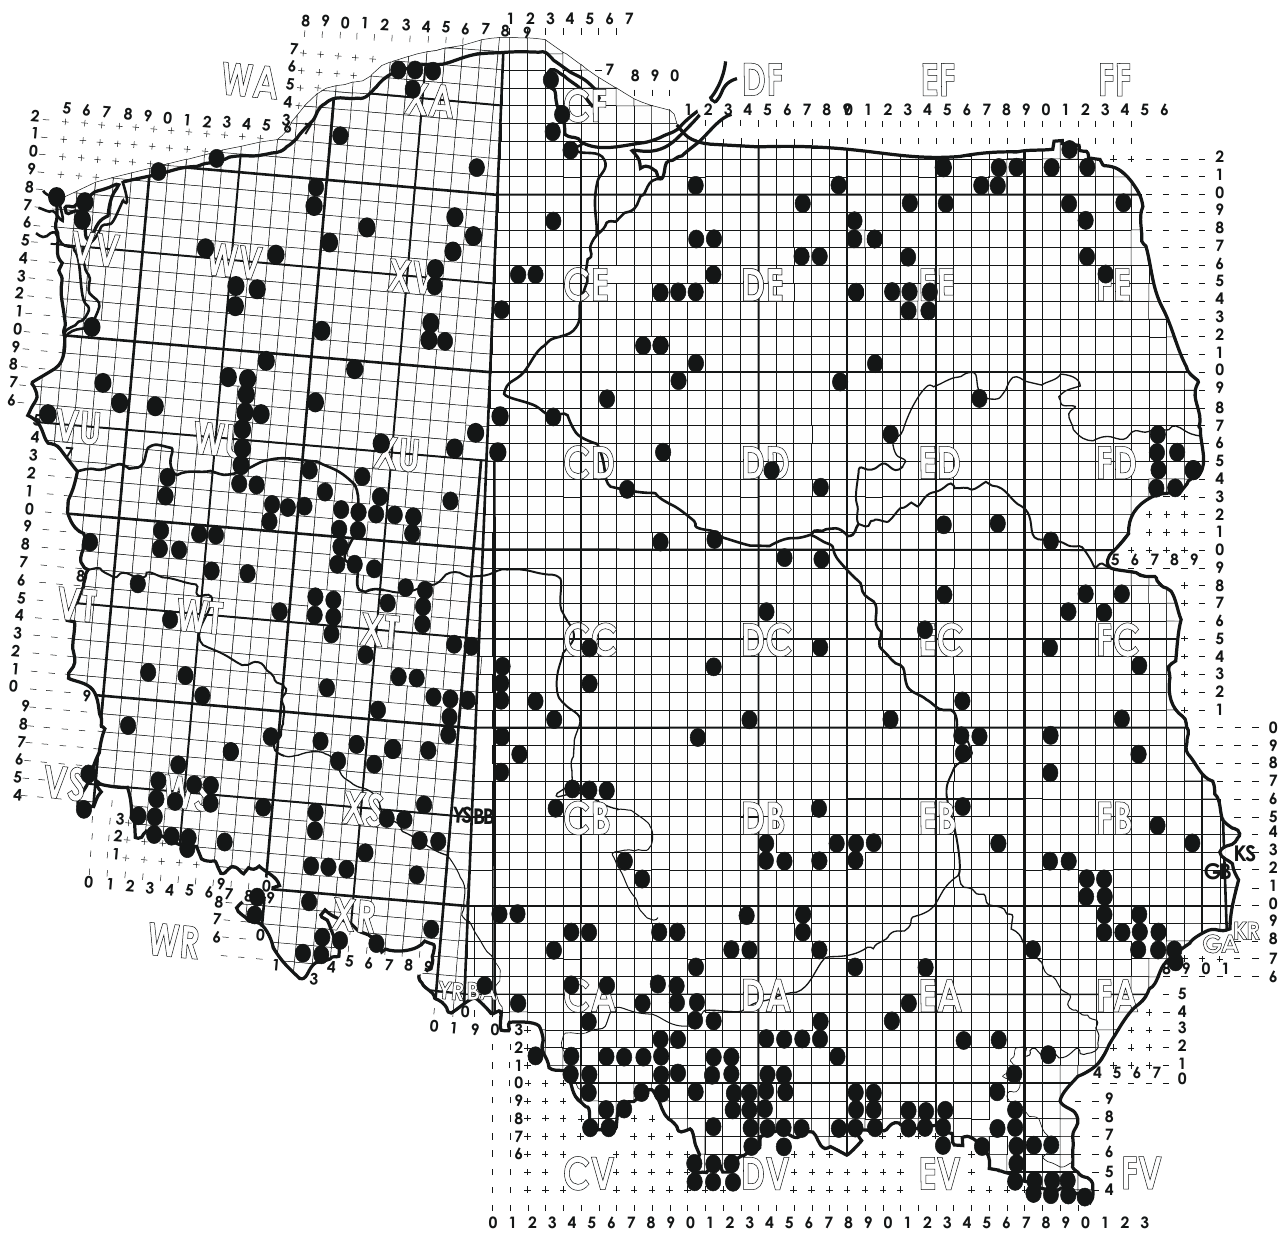
Figure 2. Geographic distribution of Trachytes aegrota as an example of a species with even distribution in the whole area of Poland (the black dots mark the locations in which the species was found).